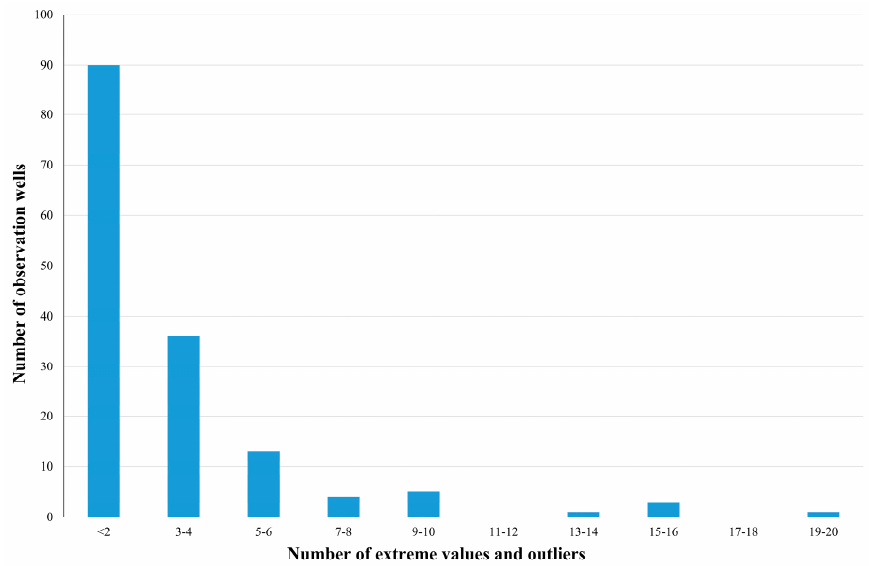
Figure 4. Observed extreme values and outliers at 153 observation wells.